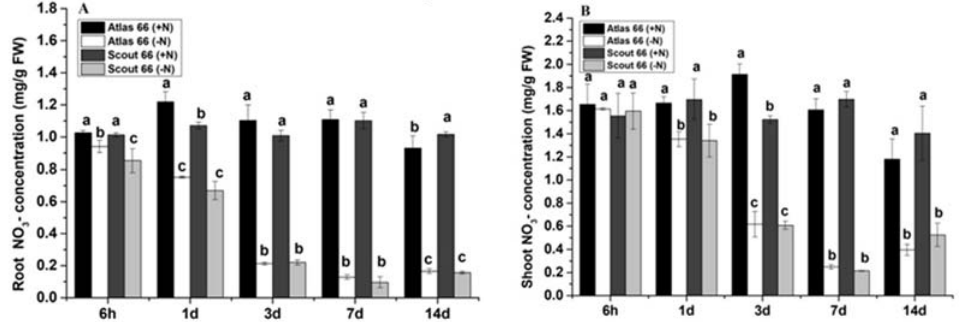
Figure 5. Effect of N deficiency on wheat plant root NO 3 − concentration ( A ) and shoot NO 3 − concentration ( B ). Wheat plants were transferred from N sufficiency to either N sufficient (2 mM) or deficient (50 μ M) conditions for a defined treatment time; data presented here were sampled from 6 h to 14 d time points from both N levels. Bars represent the mean ± SD ( n = 3). Different small letters indicate statistically significant differences based on LSD tests ( p ≤ 0.05) among the treatments and cultivars.